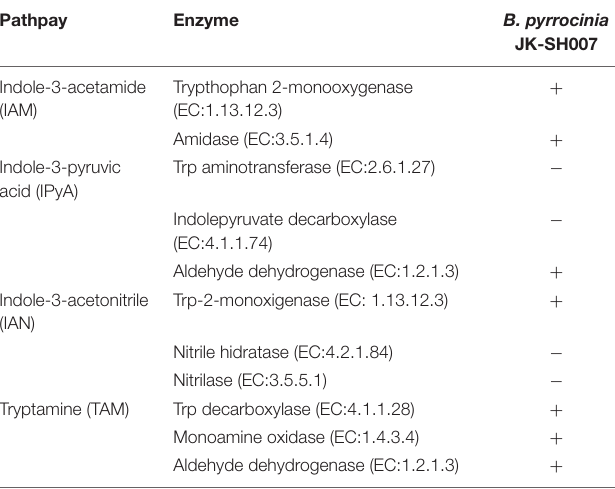
TABLE 3 | Genomic analysis of indole-3-acetic acid (IAA) biosynthesis pathways in B. pyrrocinia JK-SH007.